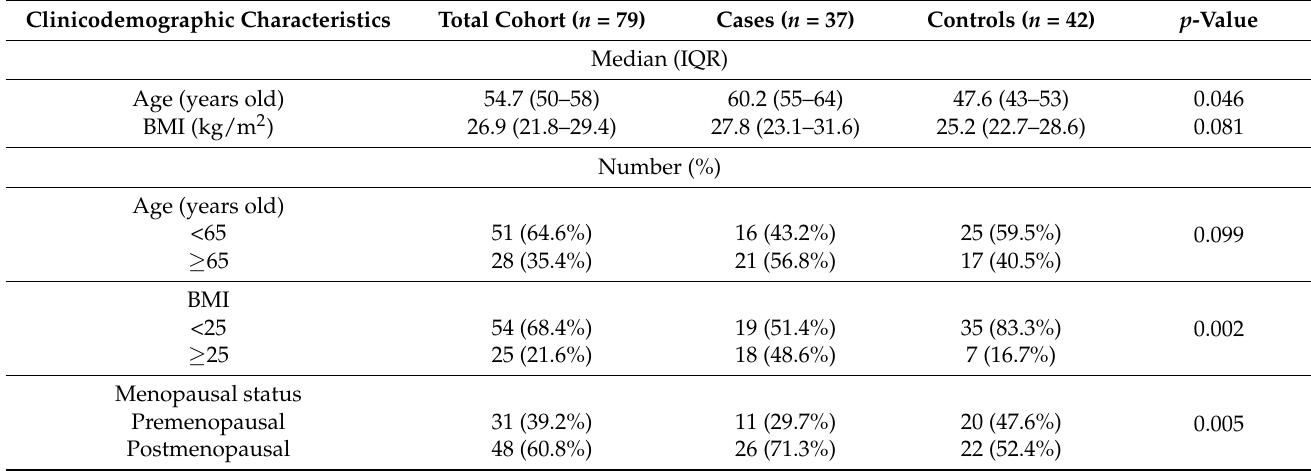
Table 2. Clinicodemographic characteristics of the patients